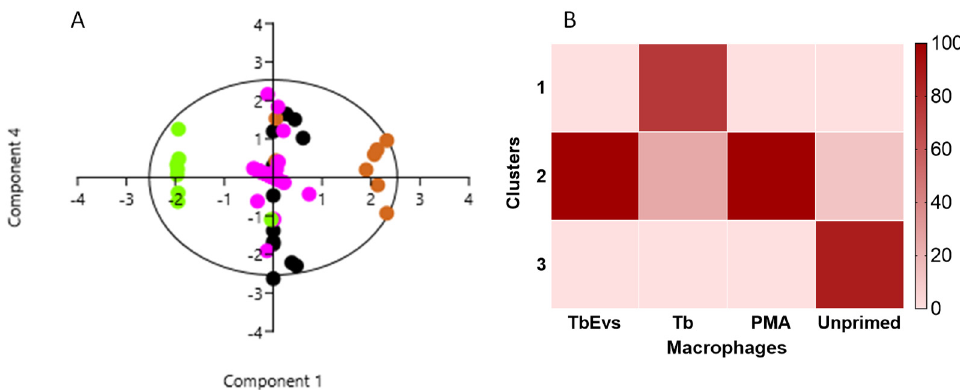
Figure 6. Influence of TbbEVs on mice macrophages. The relationship between the effect of TbbEVs (black dots), PMA (positive control, pink dots), and T. b. brucei parasites (brown dots) in MØ, including urea and NO production and density of MHCI and MHCII, is represented by a variable correlation plot ( A ). Resting MØ (negative control) are indicated by green dots. Cluster distribution of the effect TbEVs, PMA, and parasites (Tb) in MØ compared with resting cells (NC) are represented by heat map ( B ).